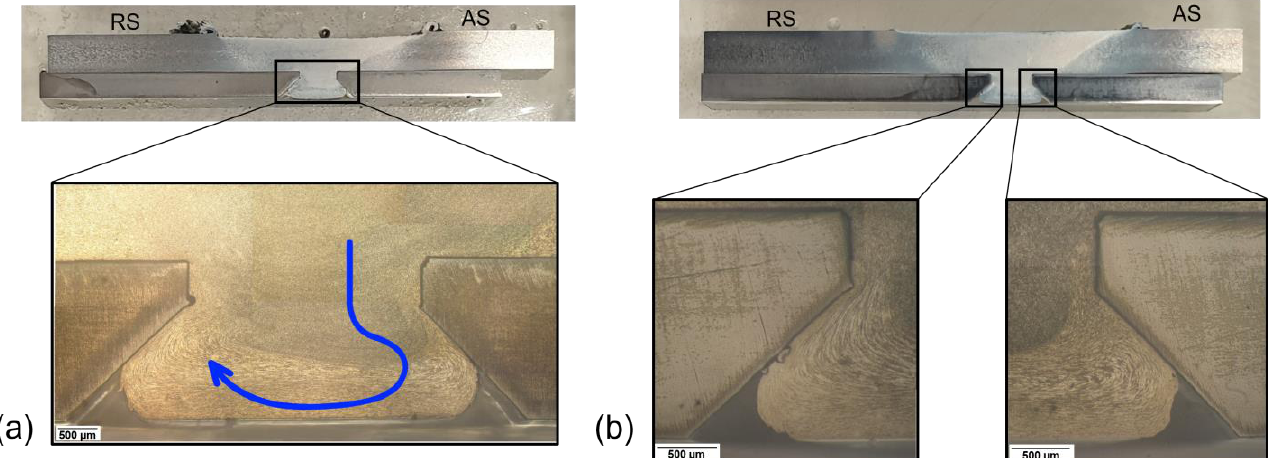
Figure 6. Detailed view of ( a ) cross-section of condition E3, where a two-dimensional arrow represents the three-dimensional flow of the material schematically, and ( b ) cross-section of condition E1 that was Kroll etched during 10 s for detailed material flow around the titanium plate chamfered holes.